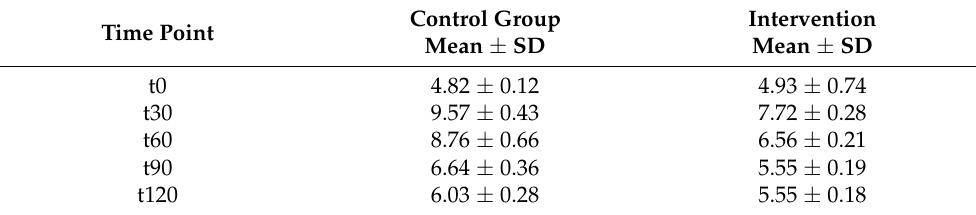
Table 3. Blood glucose levels (mmol/L) obtained for control (n = 12) and intervention (n = 12) groups at different time point: before intervention (t0), and after 30 (t30), 60 (t60), 90 (t90), and 120 (t120) minutes after intervention.